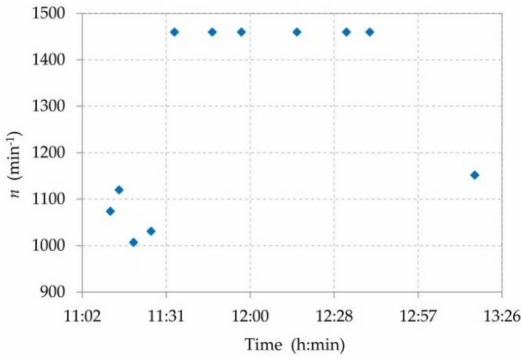
Figure 9. Electric motor rotation speeds during the measurement.